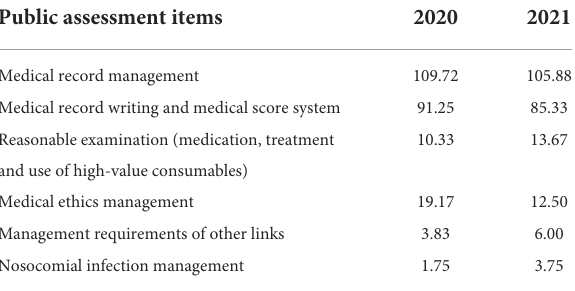
TABLE 5 The monthly average score of public assessment items in 2020 and 2021 (scores). Public assessment items